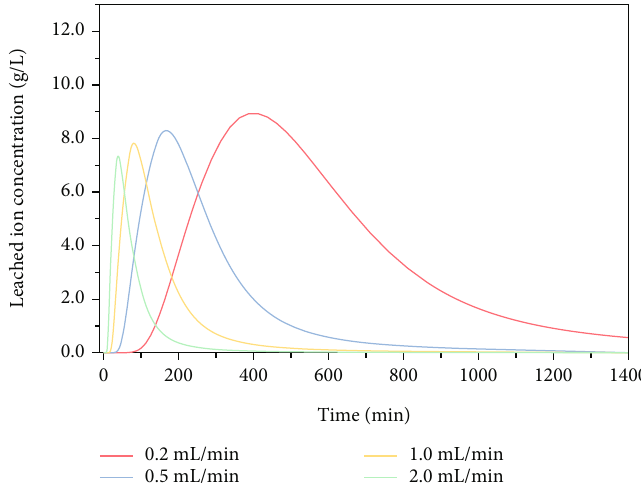
Figure 9: Variation curve of RE 3+ ion leaching concentration under di ff erent injection intensities.